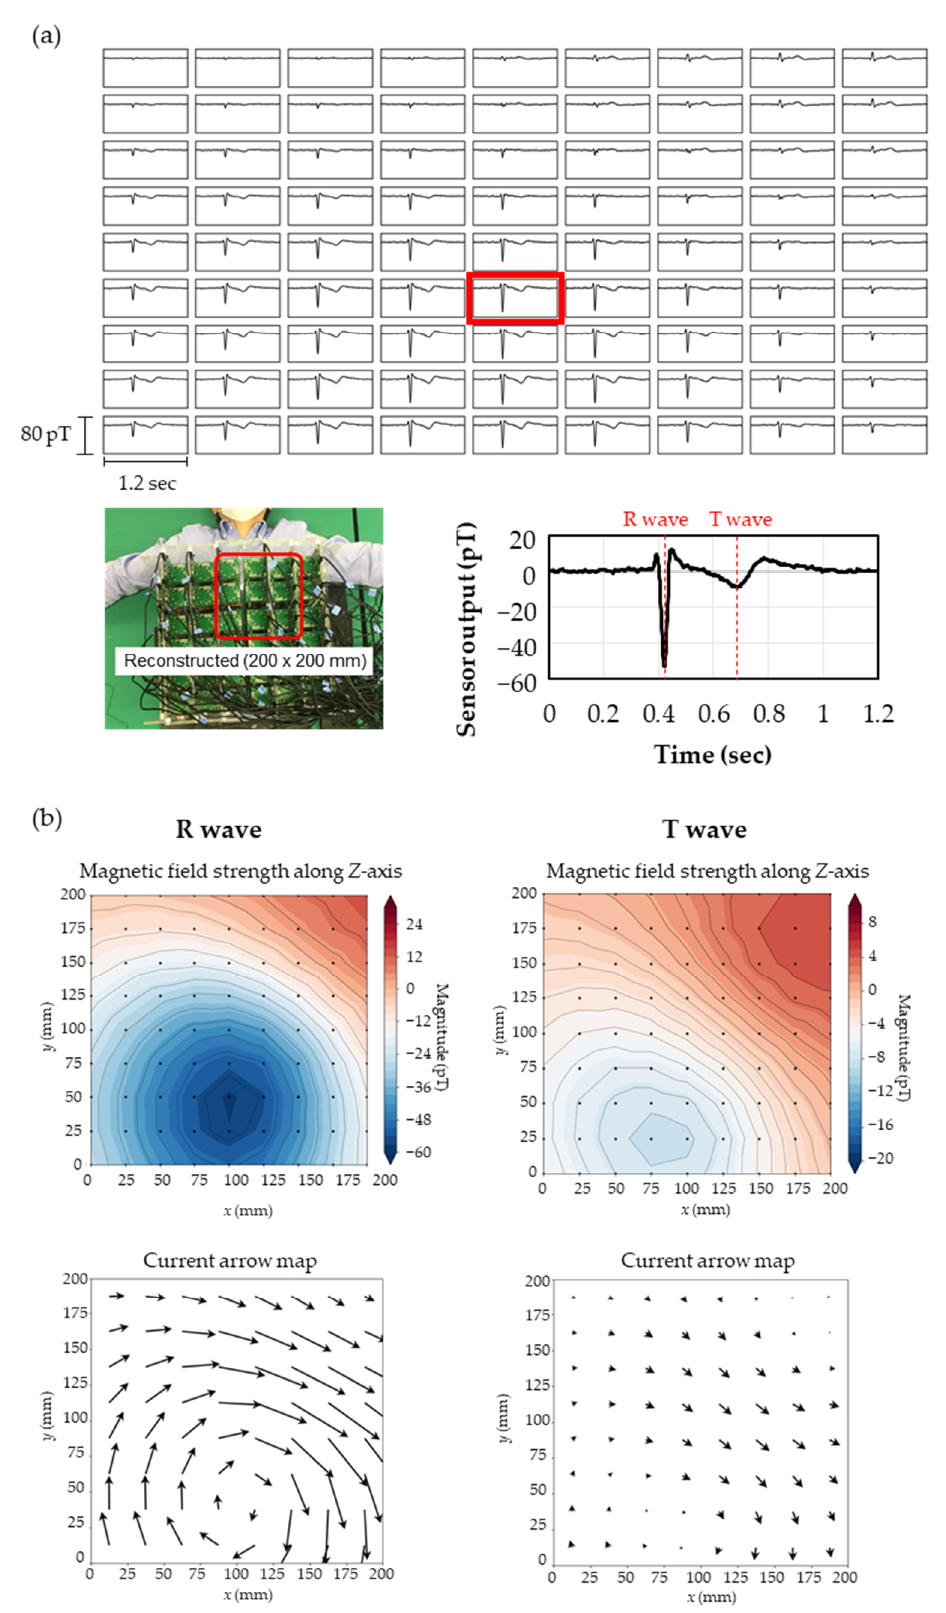
Figure 6. ( a ) Top: magnetocardiogram map reconstructed in the area of 200 × 200 mm at 40 mm above the body surface with 25 mm intervals; lower left: reconstructed area; lower right: expanded magnetocardiograph of data surrounded with the red square on the magnetocardiogram map. ( b ) Magnetic field strength maps in contour lines and current arrow maps at peaks of R and T waves.